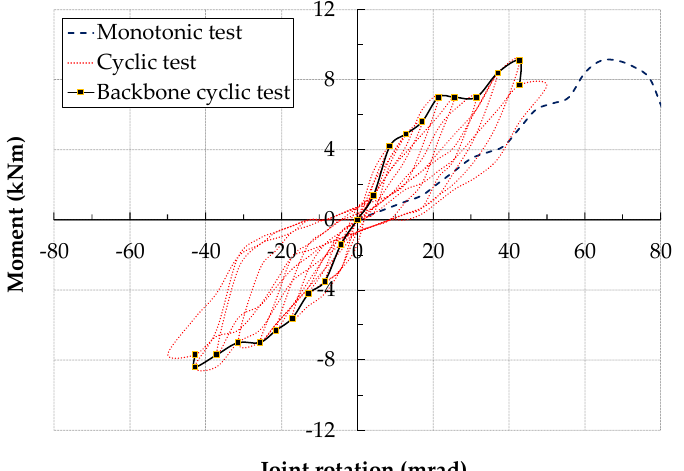
Figure 6. Cyclic moment-rotation response: SFStc2-bolted joint with flange only steel cleats.